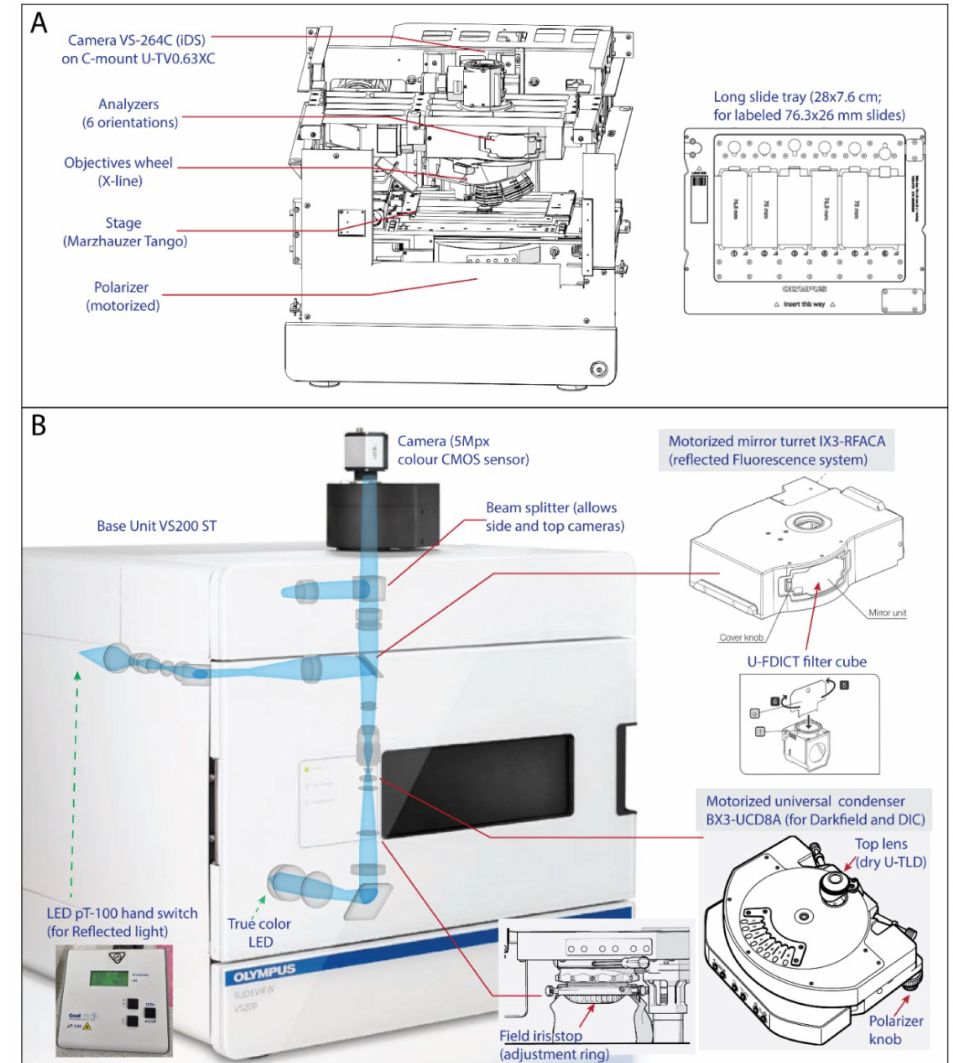
Figure 1. VS200 ST research slide scanner components. ( A ) The fundamental parts ( top-left ) are referenced (red lines) to the sketch of the base unit without housing panels ( top-right ). ( B ) The part diagrams ( bottom-right ) point out two possible optical paths ( bottom-left ) showing the source LED lamps. Copyright: Modified from Installation Manual VS200,